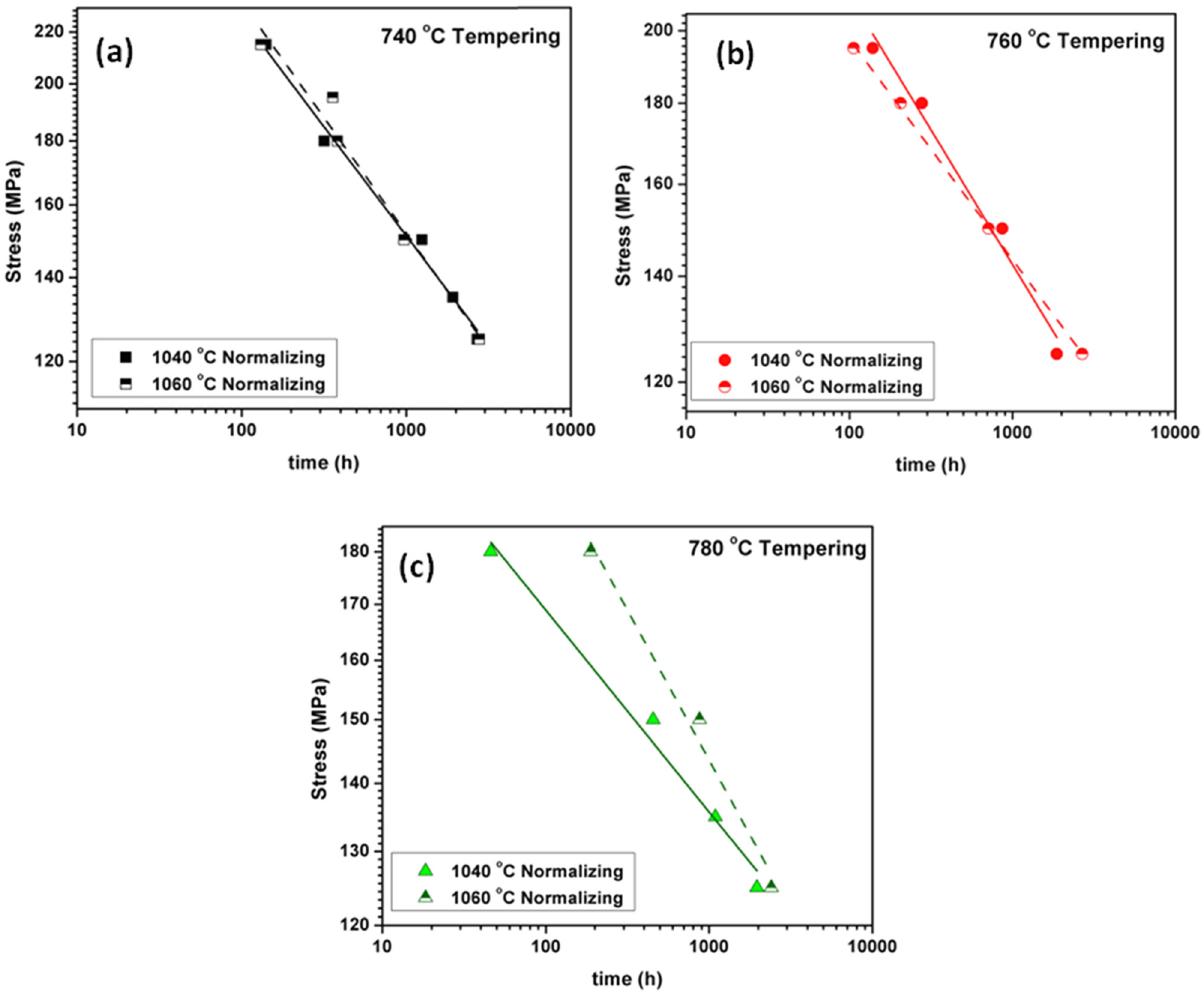
Figure 8: Summary of the stress rupture data revealing the effect of normalizing temperature for creep tests at 650°C, for tempering temperatures of ( a ) 740°C ( b ) 760°C ( c ) 780°C.